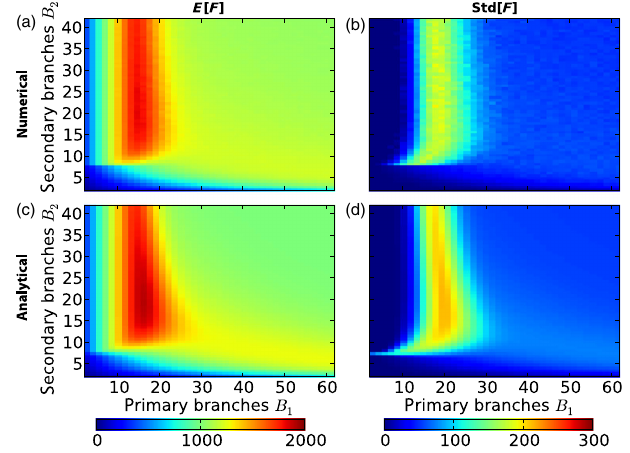
FIG. 9. Somatic input for a neuron model with two layers of nonadditive dendritic branches. Parameters are θ 1 ¼ 100 , D 200 , θ 5 , D 10 , E ½ w (cid:1) ¼ 1 , Var ½ w (cid:1) ¼ 2 , and 1 ¼ 2 ¼ 2 ¼ S ¼ 1000 ; the synaptic input arrives at the terminal branches. Numerical results for (a) the mean somatic input and (b) its standard deviation for different numbers of branches on the first ( B 1 ) and the second ( B 2 ) levels are obtained from 400 realizations of multinomially distributed synapses. The corre- sponding analytical results from Eqs. (C3) and (C6) are highlighted in (c) and (d). Analytical and numerical results agree well. The input is largest for intermediate numbers of branches B 1 ; and B 2 ; opt opt